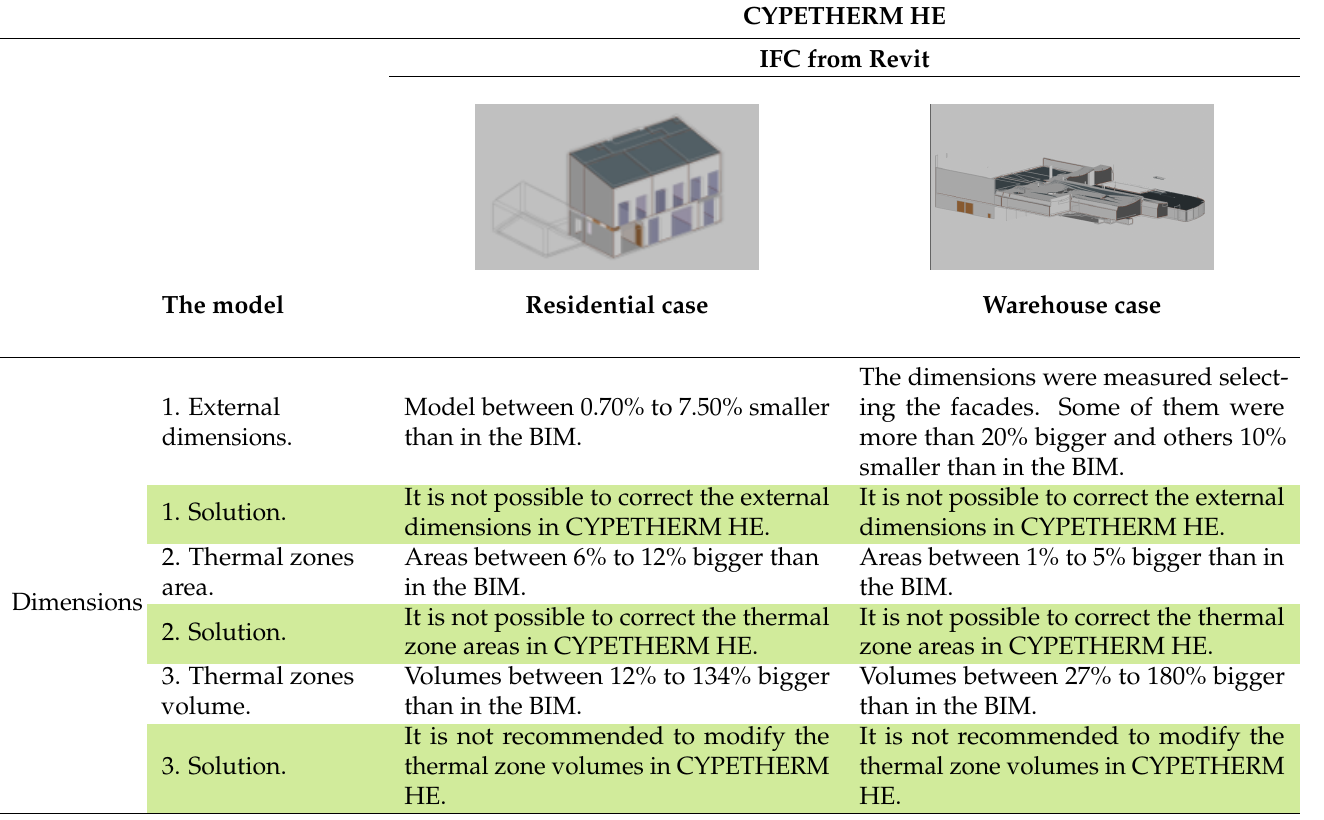
Table 3. Comparative table between IFC imported in CYPETHERM